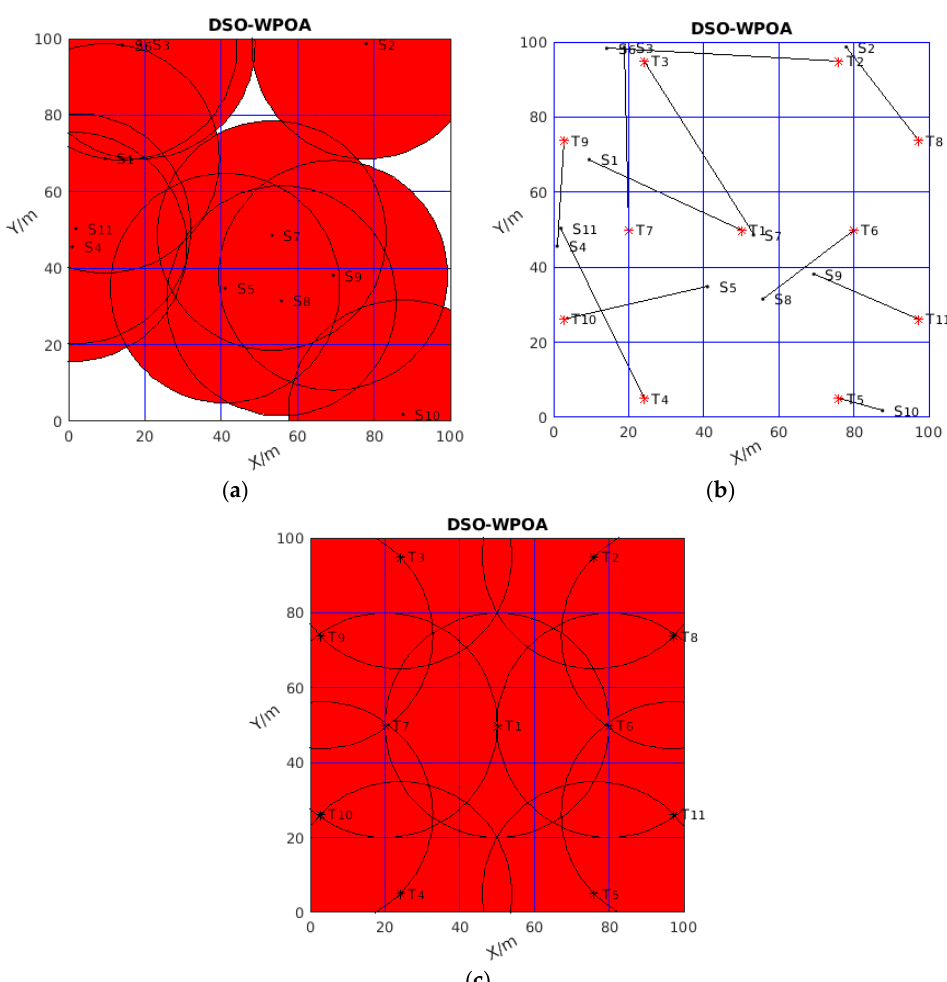
Figure 5. ( a ) The initial diagram of wireless sensor network coverage (distributed randomly); ( b ) the solution of how the movable sensors move to the targets one by one; and ( c ) the coverage that has been optimized by DSO-WPOA The red stars mean the locations of targets, while the black points mean the randomly generated initial locations of sensors, and the black lines mean the moving paths. Specifically, the parameters in the diagram correspond to the example in Section 3.